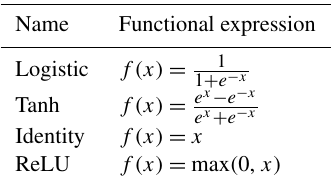
Table 4. Four commonly used activation functions for